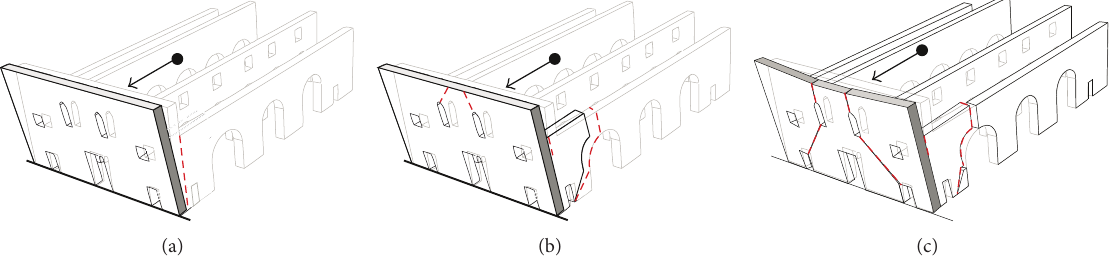
Figure 18: Mechanisms involving the fac¸ade macroelement. (a) Mechanism 1: no connection between the fac¸ade and the longitudinal walls; (b) mechanism 2: connection between the fac¸ade and the peripheral lateral walls; (c) mechanism 3: connection between the fac¸ade and all the transversal